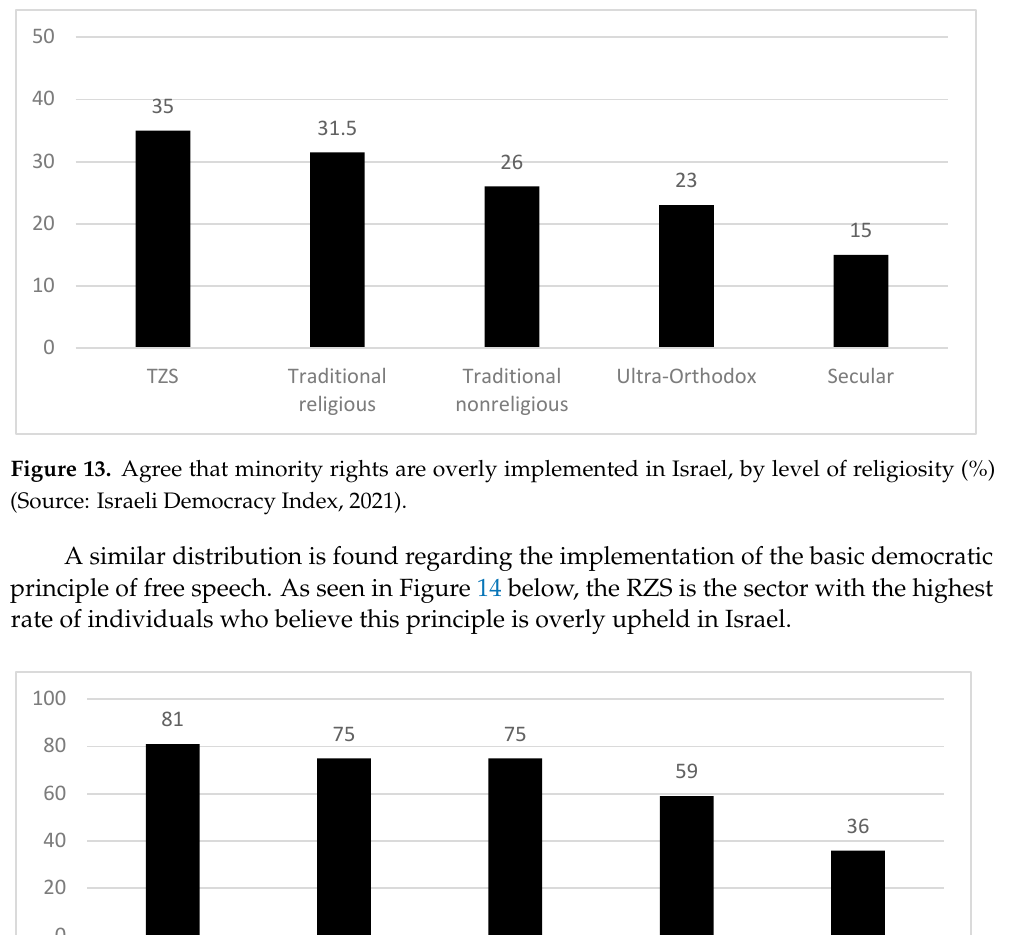
Figure 15. Agree that the free speech principle is overly implemented in Israel, by level of religiosity (%) Source: Israeli Democracy Index, 2021. The Israeli Supreme Court has been thought of for years as the bastion of Israeli liberalism. Hence its proper role is to be a central battleground between Left and Center on the one hand and the Right, with which most RZS members are affiliated, on the other. While the Left and Center support this institution and see it as the chief guardian of Israeli democracy, many on the political Right regard it as a ruthless institution that intervenes in the legislative and decision-making processes far and beyond its formal powers, thereby curtailing the elected government’s ability to govern according to its worldview and agenda. 15 Moreover, because the Supreme Court is where many appeals have been decided in the favor of Israeli Arabs and Palestinians from the West Bank, many on the political Right, including in the RZS, view the institution as a proxy of the political Left. As a result, as seen in Figure 16 below, their trust in this institution is low.